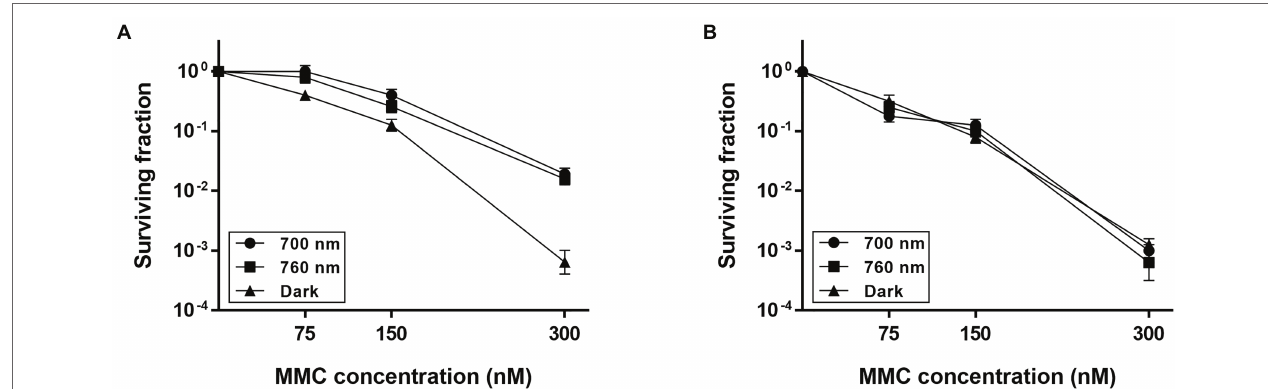
FIGURE 2 | Survival of Δ bphP during continuous exposure to mitomycin C (MMC). Deinococcus radiodurans wild-type (A) and bphP mutant (B) strains were grown to log phase, then serially diluted, and spotted on TGY plates supplemented with the indicated concentrations of MMC. The plates were incubated under red light (700 nm), far-red light (760 nm), or no light (dark) conditions for 2 days prior to the enumeration of colonies. The surviving fraction was calculated by dividing the CFUs of MMC-exposed cells by the CFUs of non-exposed cells. The error bars represent the SD of three independent experiments ( n = 3).